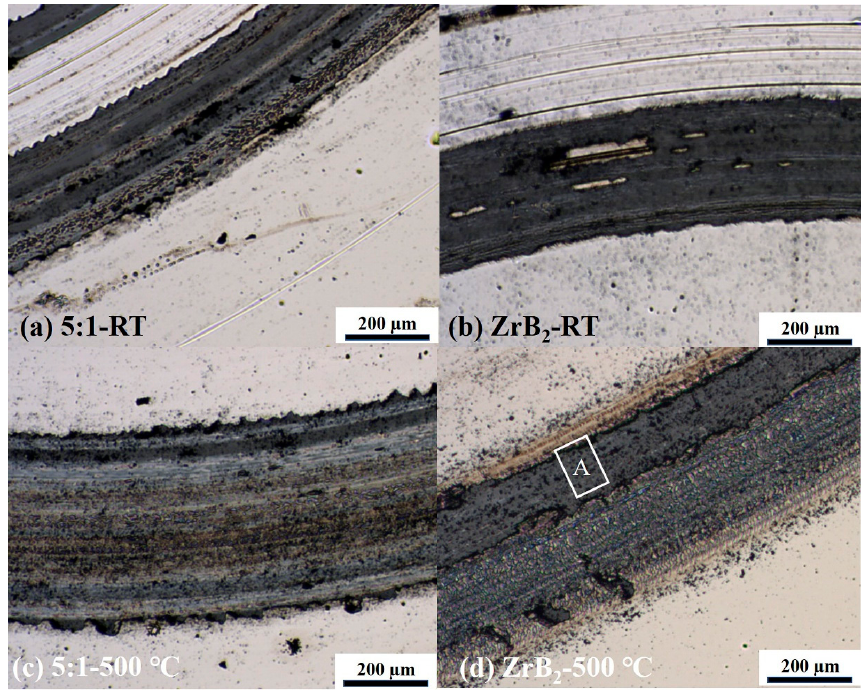
Figure 3. Worn surfaces topography of the ZrB 2 /Mo ( t ZrB2 : t Mo = 5:1) ( a , c ) and ZrB 2 ( b , d ) at different temperatures.